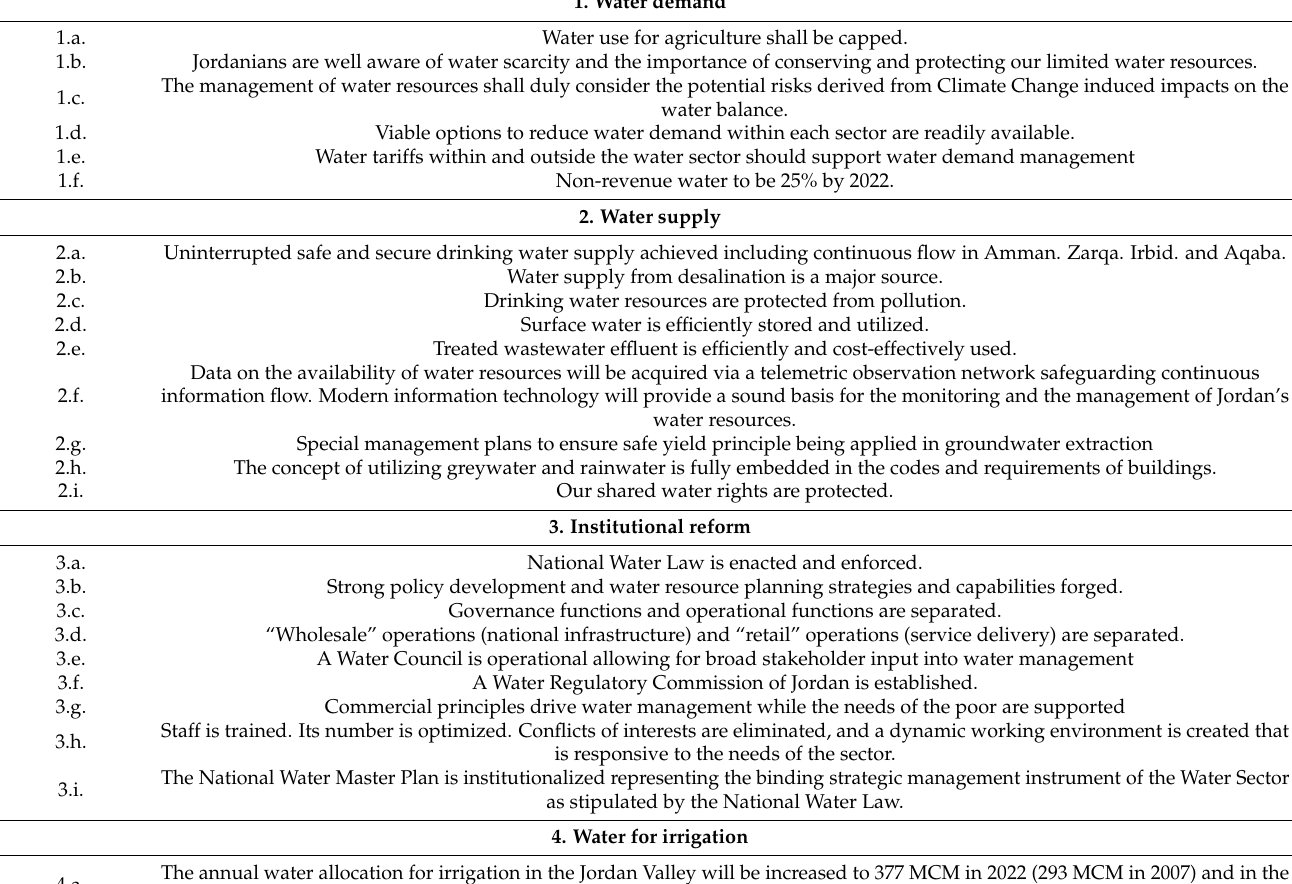
Table 2. The topics and goals of MWI strategy